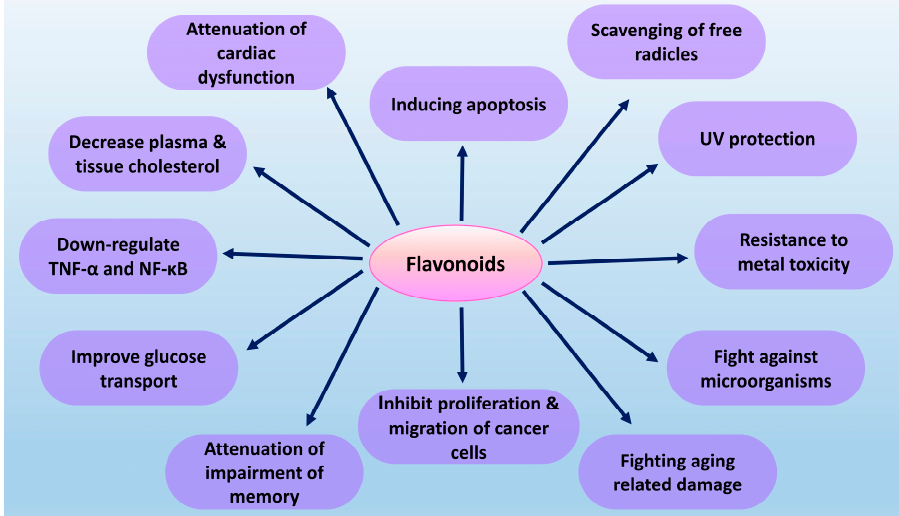
Figure 1. Biological function of flavonoids